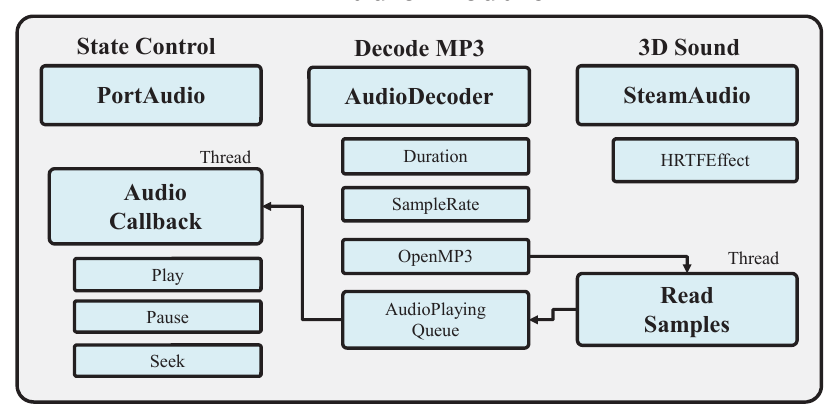
Figure 4. The audio